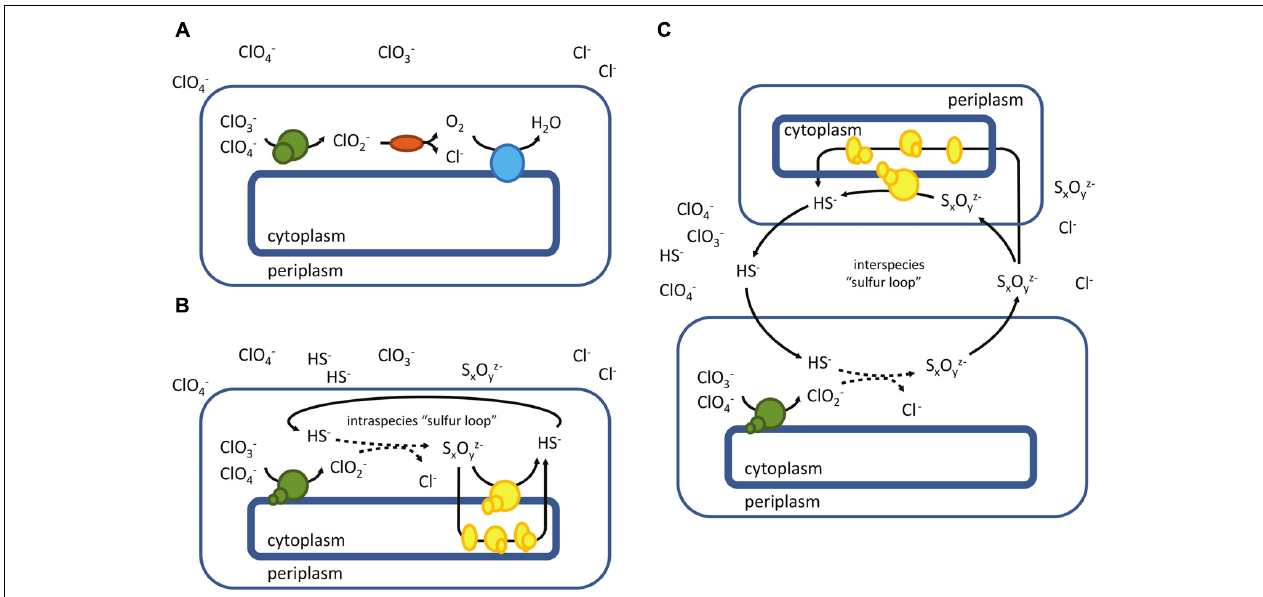
FIGURE 6 | Microbial reduction of chlorine oxyanions – a schematic overview. (A) “classical” perchlorate reduction involving a functional chlorite dismutase (Cld, mainly found in mesophilic Proteobacteria ), (B) reduction of chlorine oxyanions in the absence of Cld, employing an “intraspecies sulfur loop” (as found in A. fulgidus ), (C) potential syntrophic reduction of chlorate and perchlorate, involving interspecies sulfur transfer. Perchlorate-reducing enzymes are depicted in green, chlorite dismutase in red and terminal oxidase in blue. Enzymes involved in the reduction of oxidized sulfur compounds (e.g., S 0 , S 2 O 32 - , S 4 O 62 - , etc.) are shown in